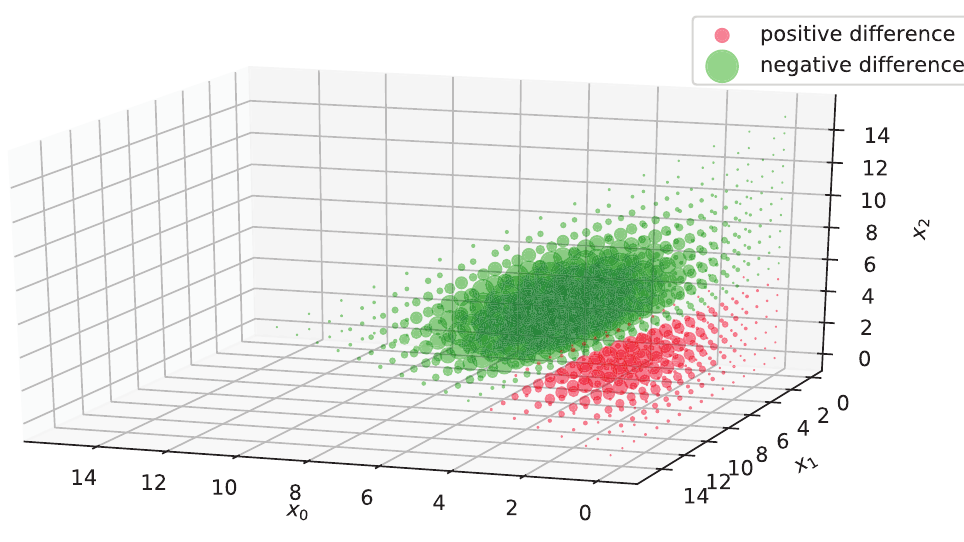
Figure 4: An example for the difference